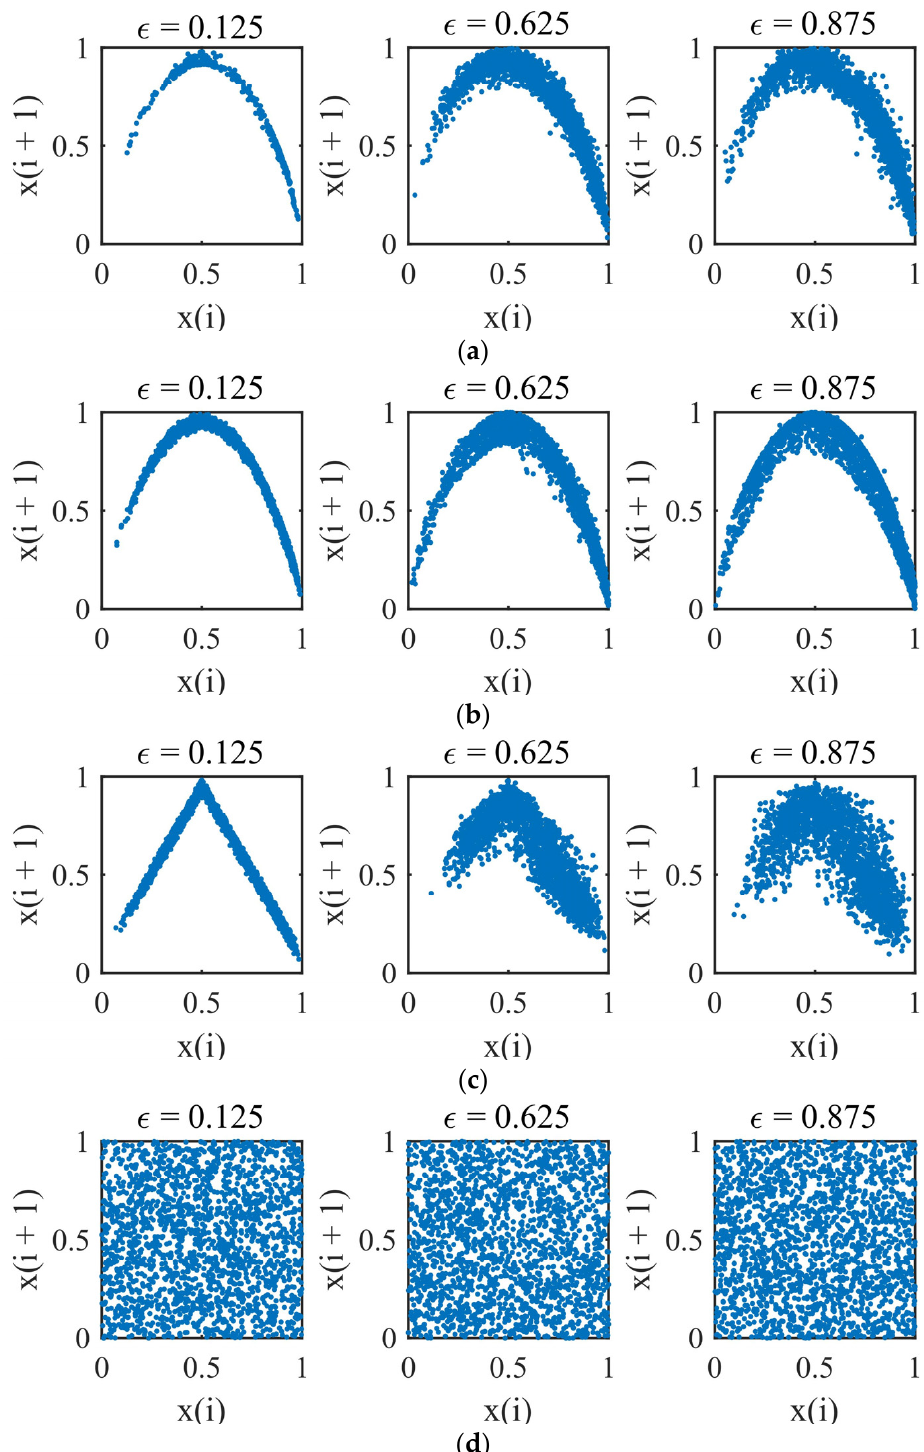
Figure 7. Return maps of ( a ) 2D-CML, ( b ) 2D-NLCML, ( c ) 2D-MCPML and ( d ) 2D-DPRCML at ε = 0.125, 0.625 and 0.875.